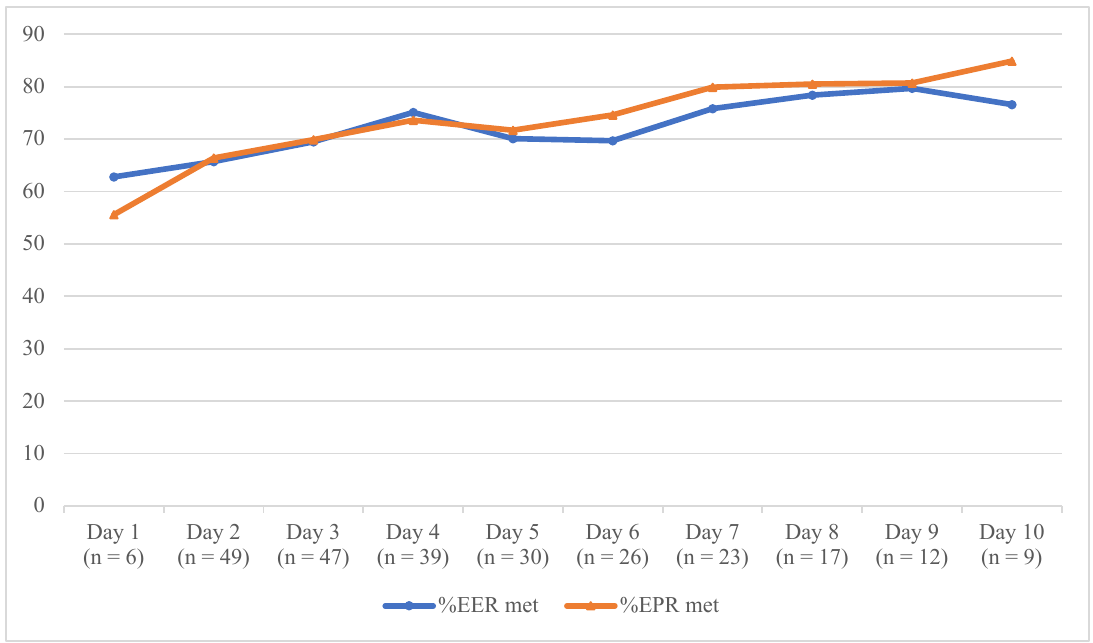
Figure 4. Mean proportion of patients’ estimated nutrition requirements met over time. %EER met: proportion of mean estimated energy requirements met; %EPR met: proportion of mean estimated protein requirements met.